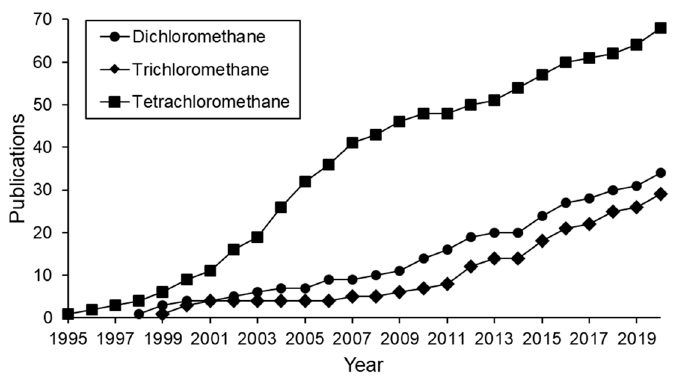
Figure 1. Evolution of publications on HDC of different chloromethanes in the last 25 years (cumulative incidence).